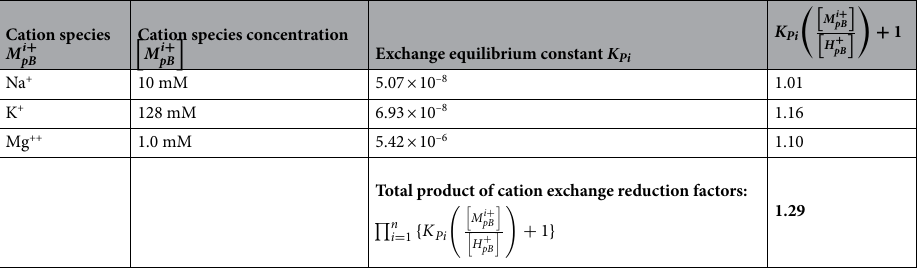
Table 1. The total product (1.29) of cation exchange reduction factors calculated from experimental cation concentrations in the bulk liquid reaction medium for mitochondria (as reported in Ref. 5,7,61 ), their associated cation-proton exchange equilibrium constants, and cation exchange reduction factors for TELP concentration at the liquid-membrane interface with the bulk liquid reaction medium pH pB = 7.25. Adapted from Ref. 5